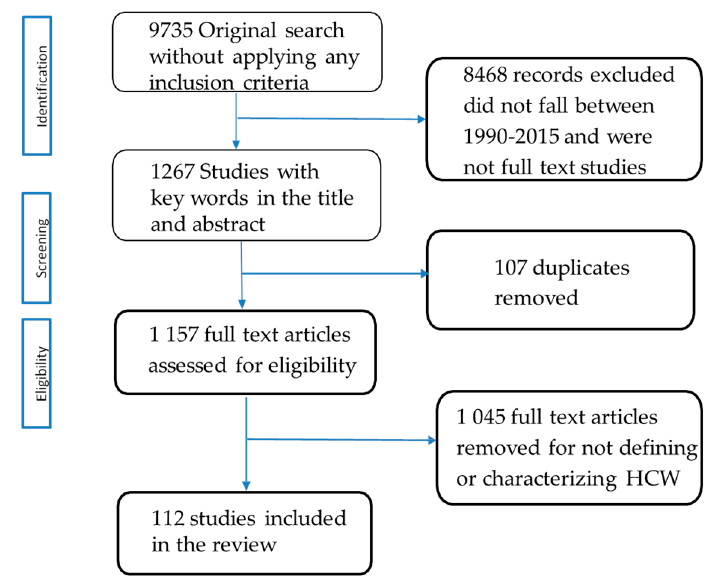
Figure 1. PRISMA flowchart of study selection process.